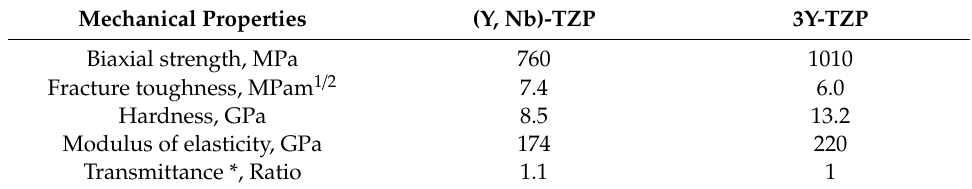
Table 1. Comparison of the mechanical properties of (Y, Nb)-tetragonal zirconia polycrystal (TZP) and